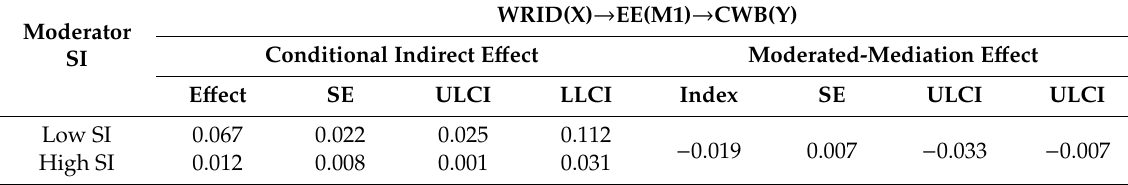
Table 4. The moderated-mediation e ff